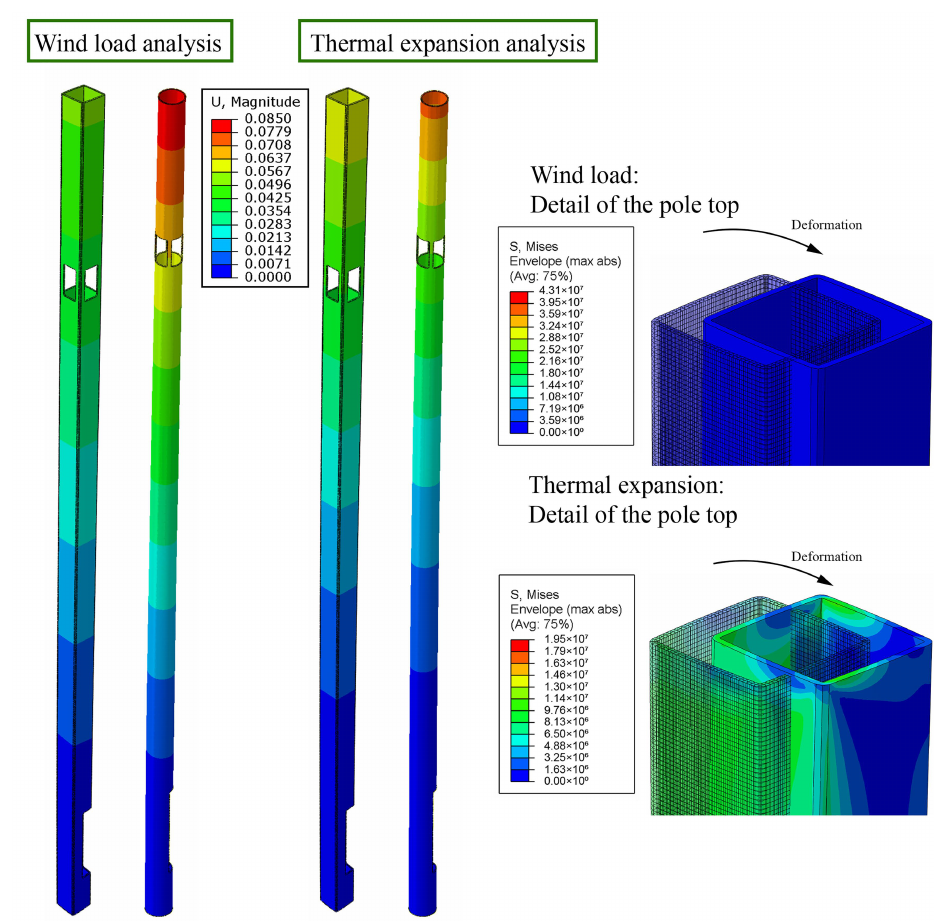
Figure 11. FEA for the deformation when the pole shaft is subjected to the standard wind load ( left side image ) and a thermal load ( right side image ). Details of the highest deformation (pole top) are shown on the